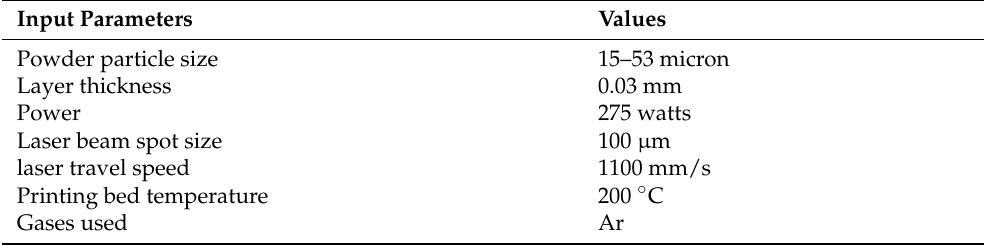
Table 1. SLM process